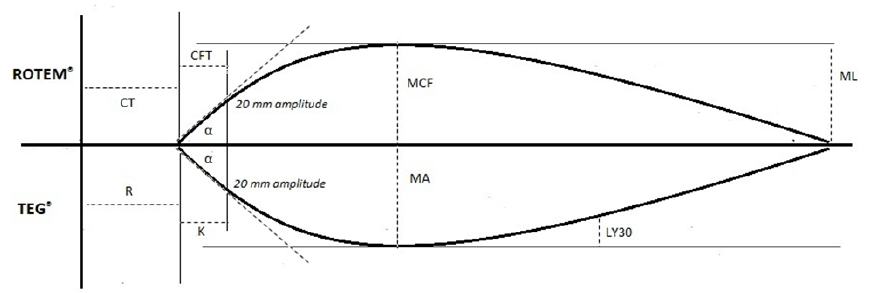
Figure 4. Illustration of thromboelastometry (ROTEM ® ) tracing and the accompanying parameters.